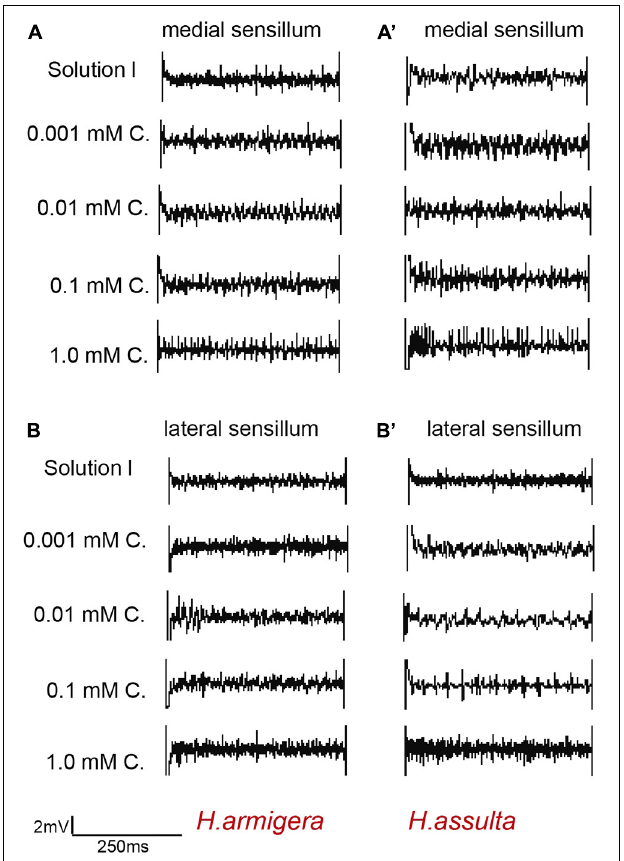
FIGURE 6 | Representative traces from responses of the styloconic sensillum of Helicoverpa caterpillars to capsaicin. (A,A’) : medial sensillum of H. armigera and H. assulta to capsaicin, respectively; (B,B’) : lateral sensillum of H. armigera and H. assulta to capsaicin, respectively. C: capsaicin. The time duration of each trace is 500